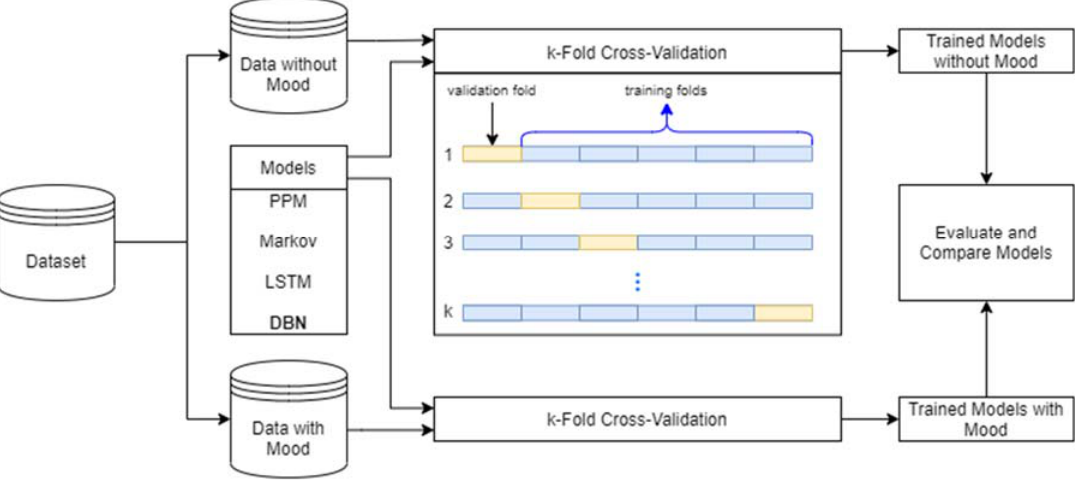
Figure 6. The flow of the experiment.